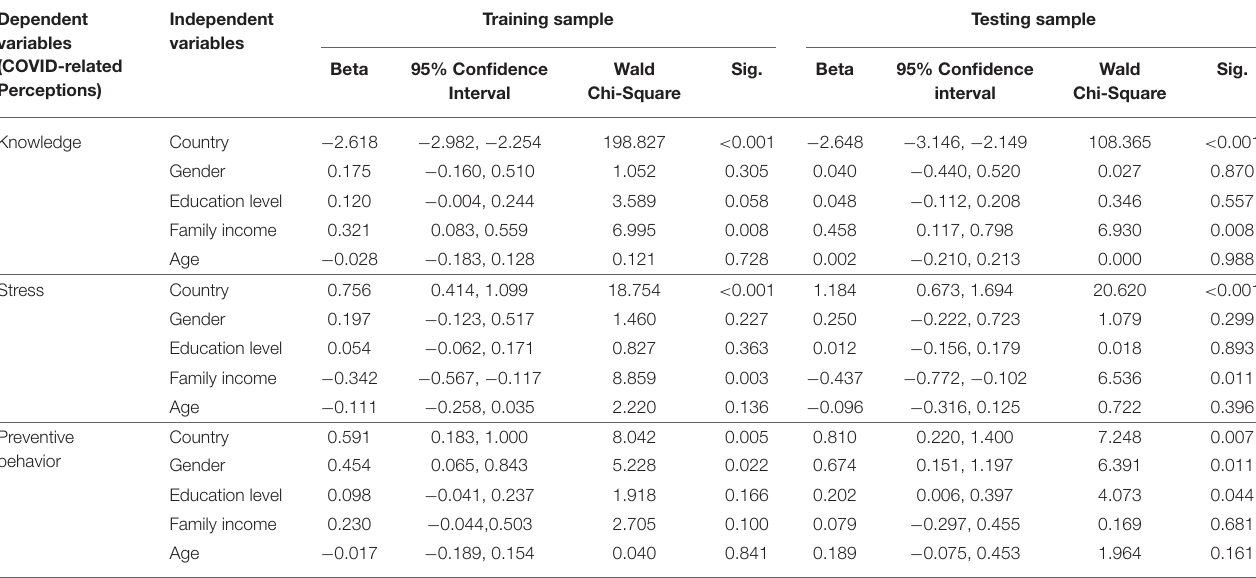
TABLE 2 | Generalized linear model (GLM) demonstrating a significant association between country of residence of the participants (India vs. the USA) and COVID-related perceptions, while adjusted for gender, education level, family income, and age. Dependent Independent Training sample Testing sample variables variables (COVID-related Beta 95% Confidence Wald Sig. Beta 95% Confidence Wald Perceptions) Interval Chi-Square interval Chi-Square